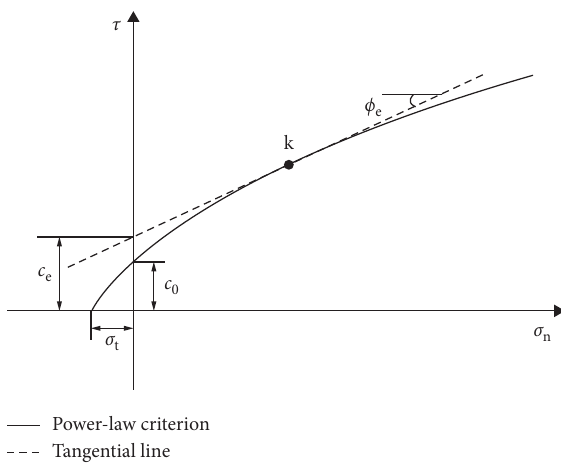
Figure 1: Tangent line to nonlinear strength